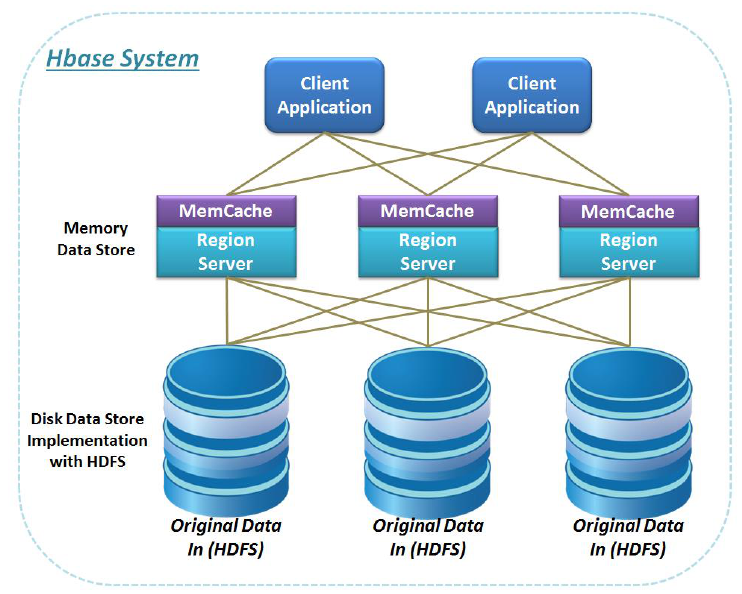
Figure 2. Architecture of HBase NoSQL Database System management.